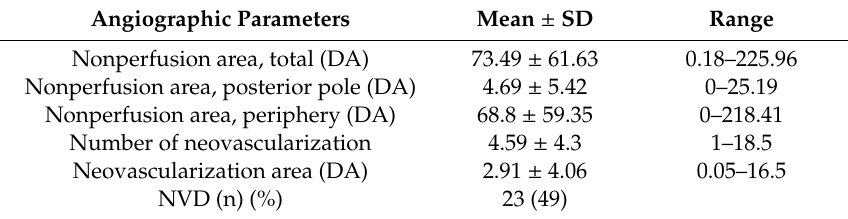
Table 2. Nonperfusion areas, neovascularization area, and